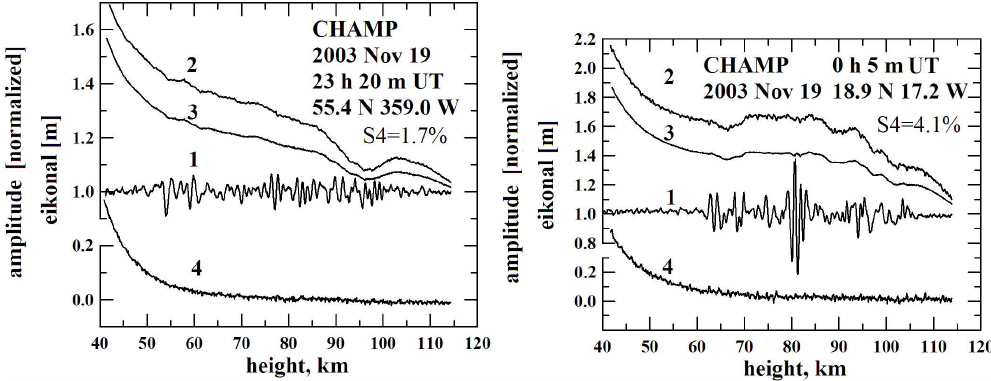
Fig. 2. Amplitude and excess phase measurements of the CHAMP RO signals in both quiet (left) and slightly disturbed (right) ionosphere (events no. 0211 and 0001, 19 November 2003). Local time of the event and the coordinates of the RO ray perigee T are shown in the graphs. The S 4 index value is shown in the lower line of the insert. The amplitude curve 1 has low variations with index S 4 =1.7% (left) and S 4 =4.1% (right). The phase path (eikonal) excesses 8 1 (t) and 8 2 (t) at f 1 , and f 2 are shown by curves 2 and 3, respectively. Curve 4 corresponds to the combined eikonal 8(t)